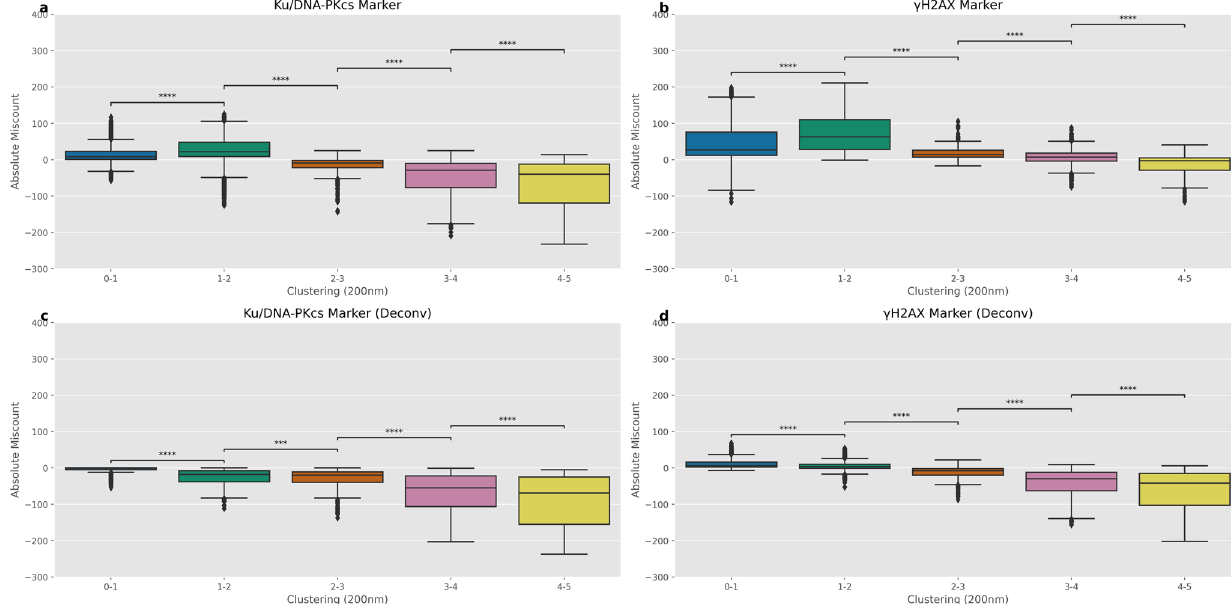
Fig. 8 Categorising the magnitude of absolute miscounting as a function of DSB clustering. The values of clustering are calculated based on the known amount of DSBs within the cell nucleus at a given time point. Clustering equates to the average number of DSBs within proximity to each DSB within the simulated cell nucleus. Where proximity for this study is characterised as 200 nm. Clustering is increased for early time points, higher dose, higher LET and is decreased for the opposite. Therefore, the clustering combines time, dose and radiation type parameters into a single metric. a , b are for the DSB and γ - H2AX markers respectively. c , d are for the DSB and γ -H2AX markers with perfect deconvolution respectively. Error bars correspond to 1.5 times the interquartile range in either direction. Mann – Whitney test between categorised clustering values to highlight statistically signi fi cant differences. p values have been adjusted using the Bonferroni correction. Signi fi cance notation refers to the following thresholds: ns = p > 0.05, * p > 0.01, ** p > 1e − 3, *** p > 1e − 4, **** p < 1e − 4. All microscope images have been emulated using the Airyscan ×63 point spread